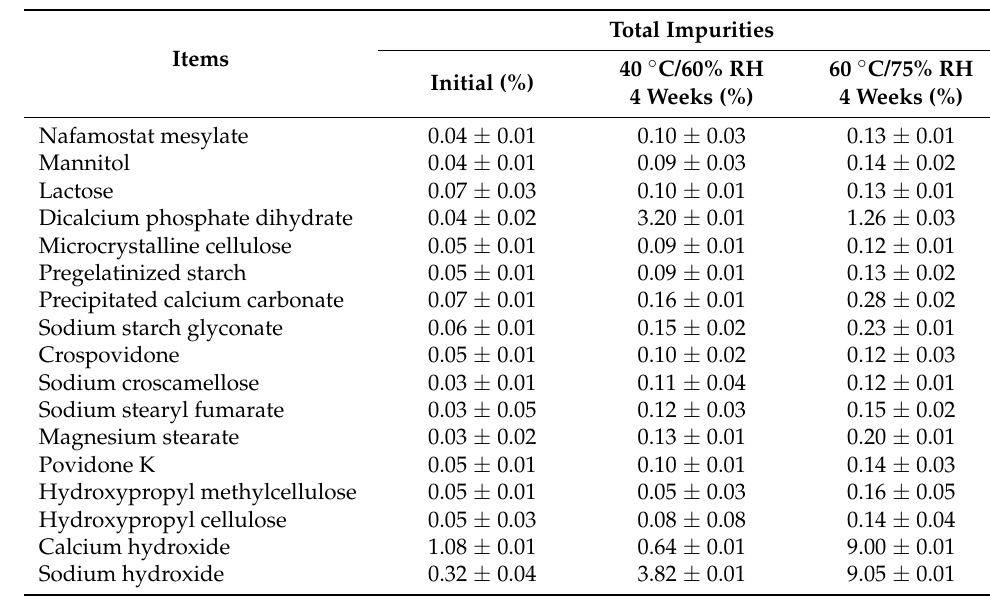
Figure 2. Compatibility test of nafamostat mesylate and each excipient using DSC. Table 3. Total impurities of compatibility test between nafamostat mesylate and each excipient via HPLC (%).